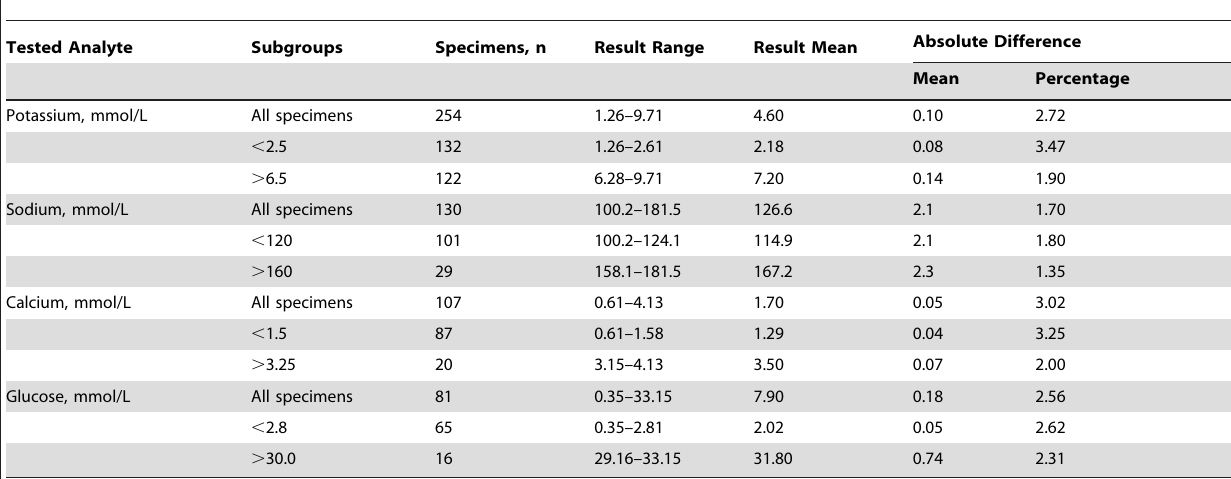
Table 3. Mean Absolute and Percentage of Difference between the Two Runs for Specimens Originally Classified as Within the